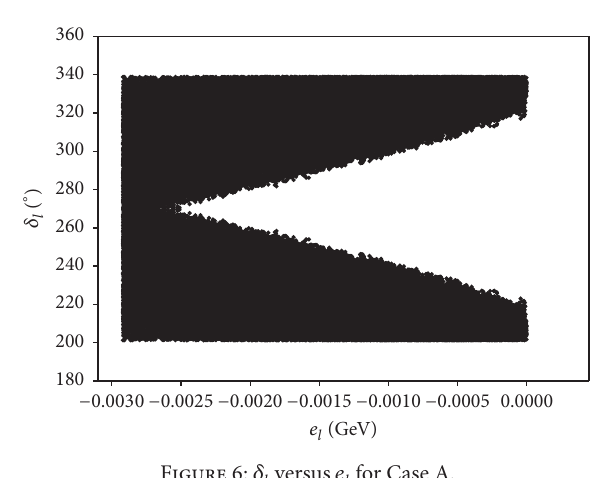
∘ 2 ≳ 0.5 compatible and 𝑠 23 2